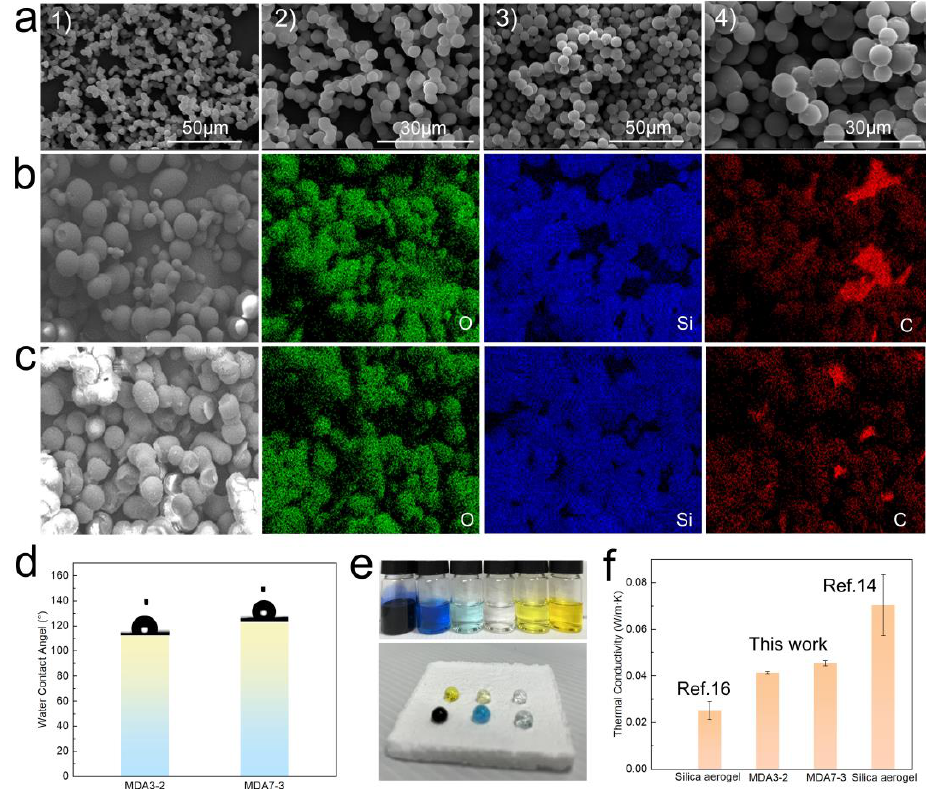
Figure 2. ( a ) SEM images of the MDAs: 1 and 2 are MDA3-2, 3 and 4 are MDA7-3; ( b ) EDX mapping of MDA3-2: the O, Si, and C elements are highlighted in green, blue, and red, respectively; ( c ) EDX mapping of MDA7-3: the O, Si, and C elements are highlighted in green, blue, and red, respectively; ( d ) contact angles of the MDAs; ( e ) photo images of colored water and their droplets on MDA; ( f ) thermal conductivity of the MDAs.